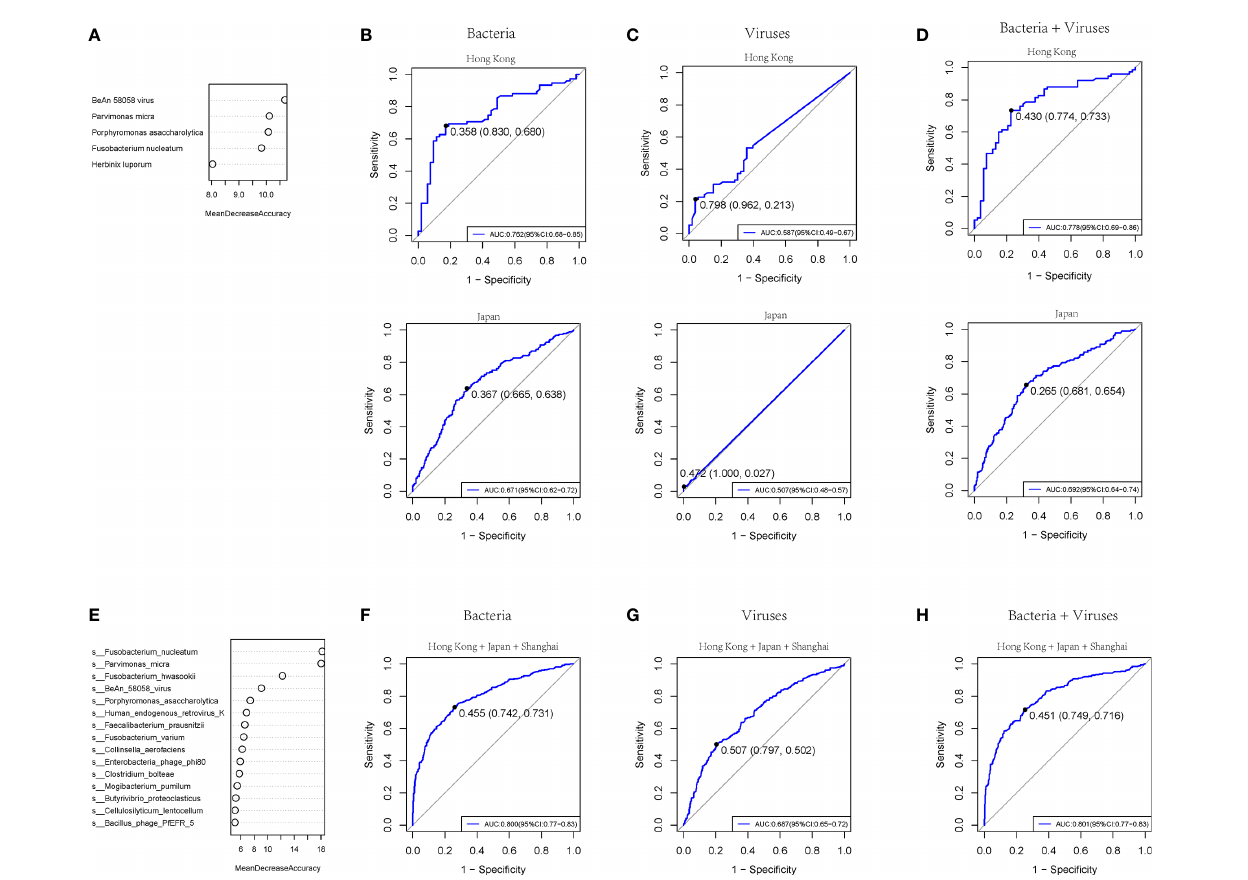
FIGURE 5 | The prediction ability of bacterial and viral markers for colorectal cancer. (A) Importance ranking of the fi ve bacterial or viral species based on random forest analysis. (B) The prediction performance of the fi ve bacterial markers for the validation cohort of Hong Kong (upper panel) or Japan (lower panel). (C) The prediction performance of 5 viral markers for the validation cohort of Hong Kong (upper panel) or Japan (lower panel). (D) The prediction performance of 5 bacterial and fi ve viral markers for the validation cohort of (upper panel) or Japan (lower panel). (E) Importance ranking of 15 bacterial and viral species based on random forest analysis across Hong Kong, Japan, and Shanghai cohorts. (F) The prediction performance of 15 bacterial markers for the three cohorts. (G) The prediction performance of 15 viral markers for the three cohorts. (H) The prediction performance of a 15-component panel of bacteria and viruses for the three